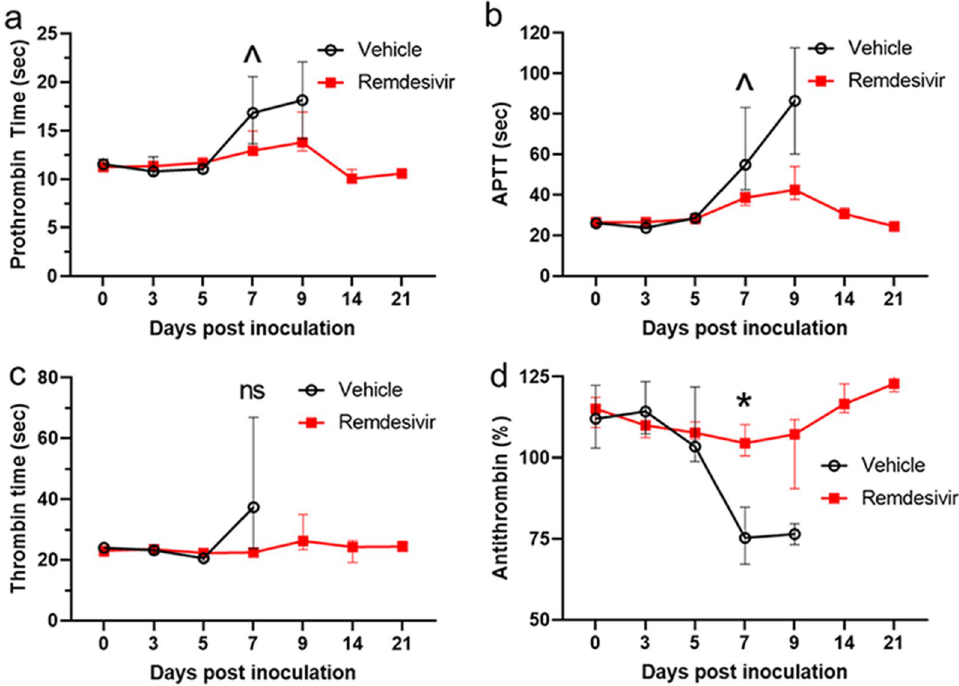
Figure 3. Clinical pathology. Trends toward increased clotting time were observed in vehicle treatment (black open circles) versus remdesivir treatment (red filled squares) groups for ( a ) prothrombin time, ( b ) activated partial thromboplastin time (APTT), and ( c ) thrombin time. ( d ) Anthithrombin (%) on day 7 PI is significantly reduced in control group (black open circles) versus remdesivir treatment group (red filled squares) with p = 0.03. Values represent the group medians and interquartile ranges, with *p < 0.05, ^p < 0.10; ns not